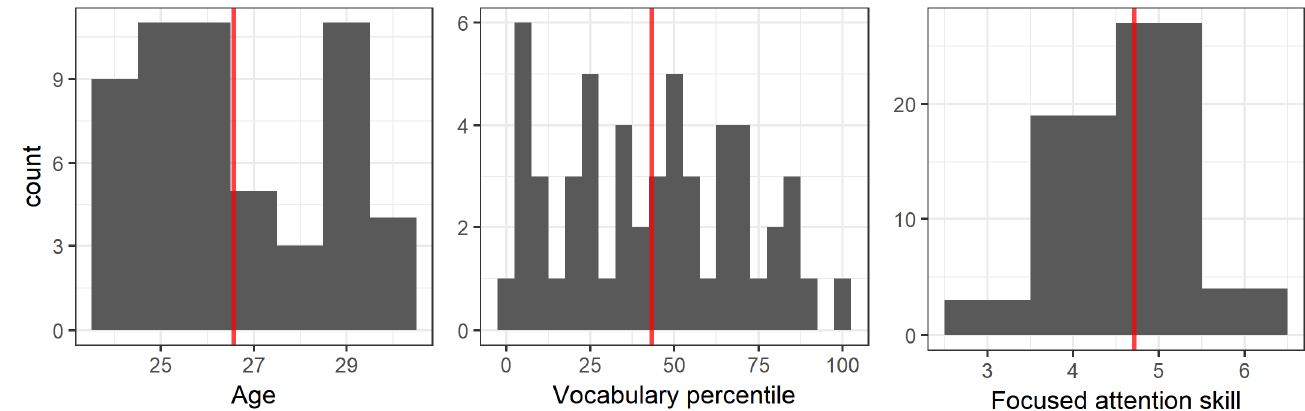
Figure 3. Histograms for age, vocabulary percentile and focused attention skill. Red lines show means. Table 1. (A) Descriptive statistics for age, vocabulary percentile, and focused attention skill. ( B ) Pairwise correlations for age, vocabulary percentile, and focused attention skill.